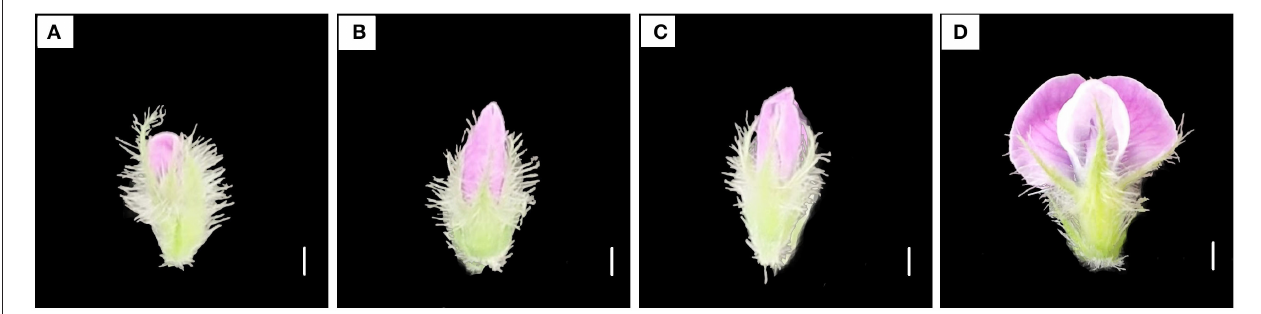
FIGURE 1 | Flower characteristics at four developmental stages. (A) Petal-emerging stage; (B) Petal-elongated stage; (C) Initially-open stage; (D) Fully-open stage. Scale bar, 1mm.